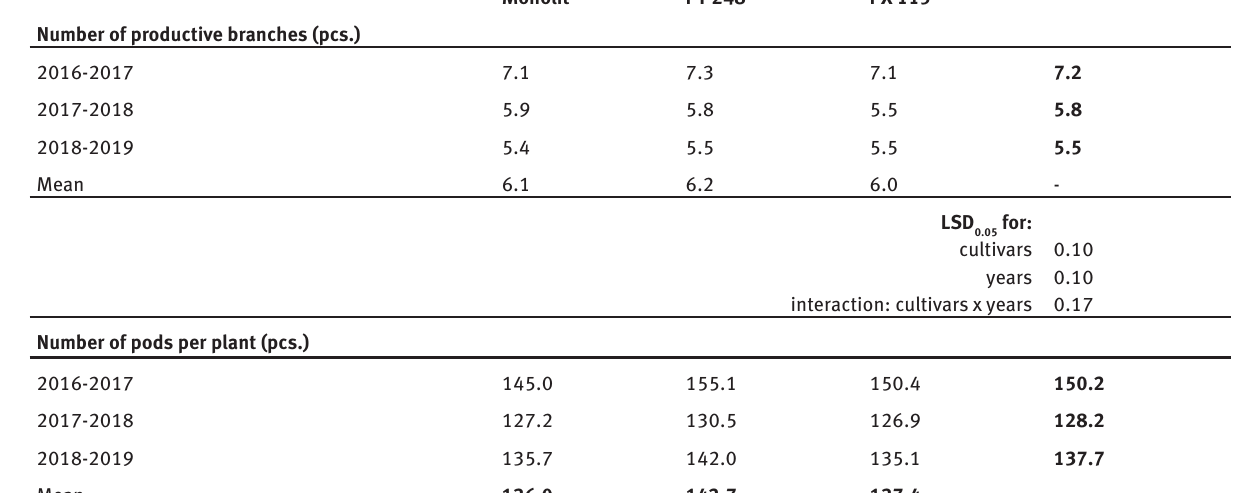
Cultivars Monolit PT 248 PX 115